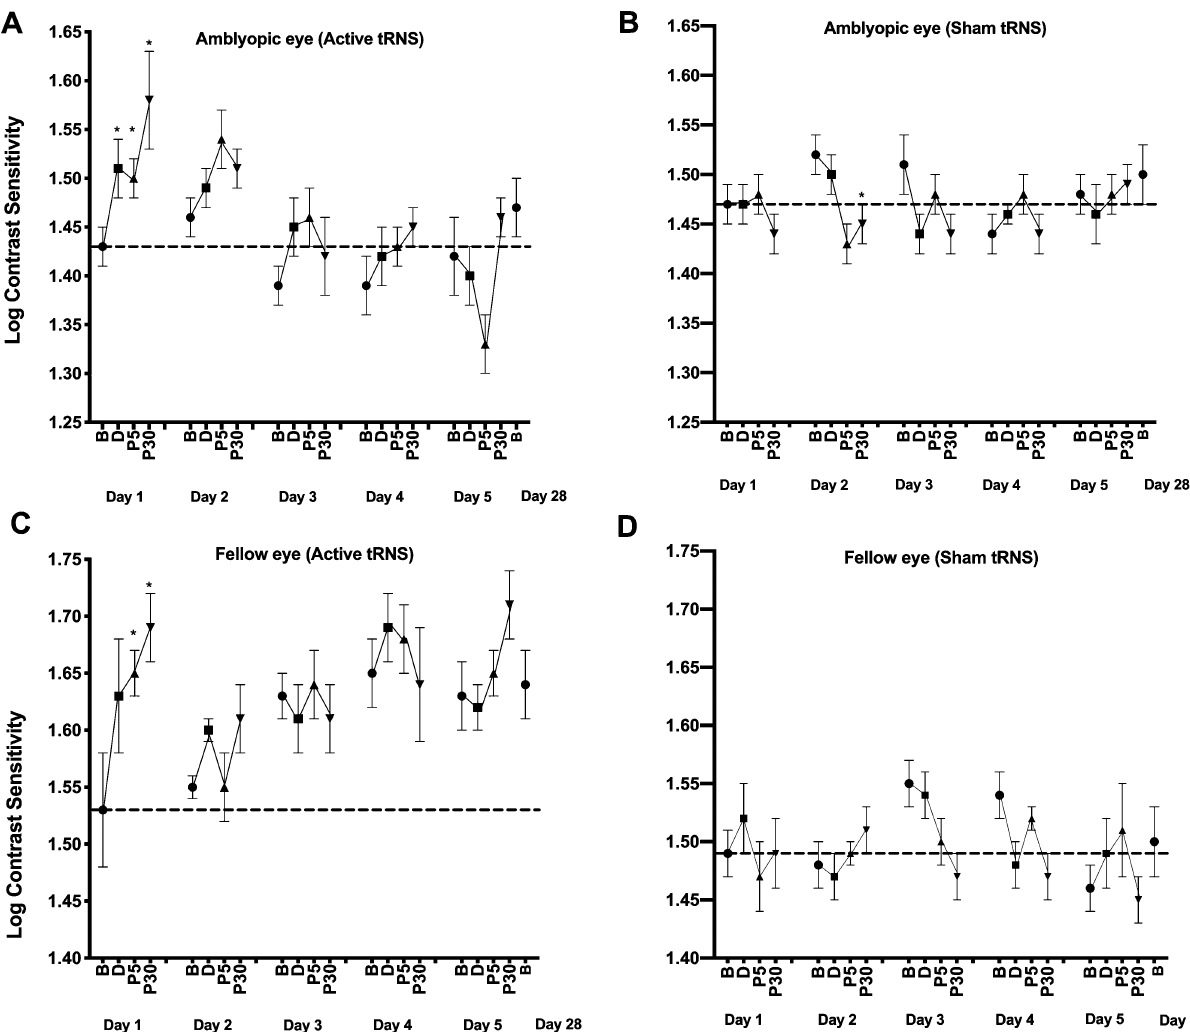
Figure 3. The effects of tRNS on contrast sensitivity during each daily session and at the day 28 follow-up visit. Data are shown separately for the amblyopic ( A and B ) and fellow ( C and D ) eyes and for the active ( A and C ) and control ( B and D ) groups at baseline and during, 5 min (P5) and 30 min (P30) post tRNS. *Statistically significant difference from baseline (p < 0.05). Error bars show within-subject standard error of the mean (SEM). The dashed horizontal lines represent the mean before-stimulation threshold on day 1. Larger y-axis values indicate better contrast